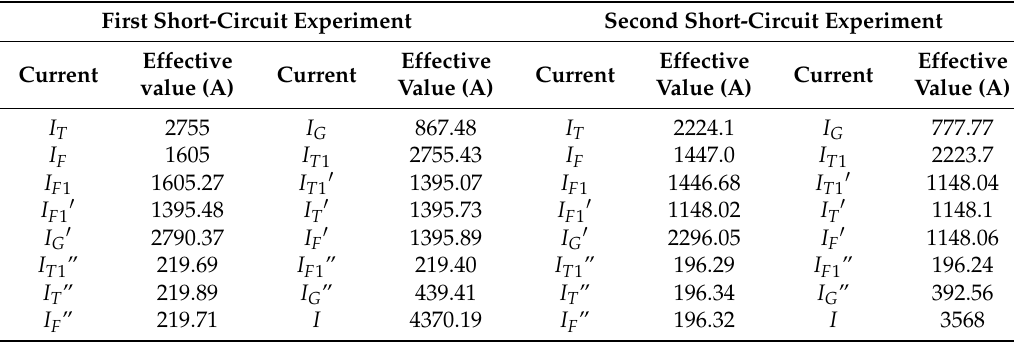
Table 3. Measurement record of currents of the short-circuit experiments.